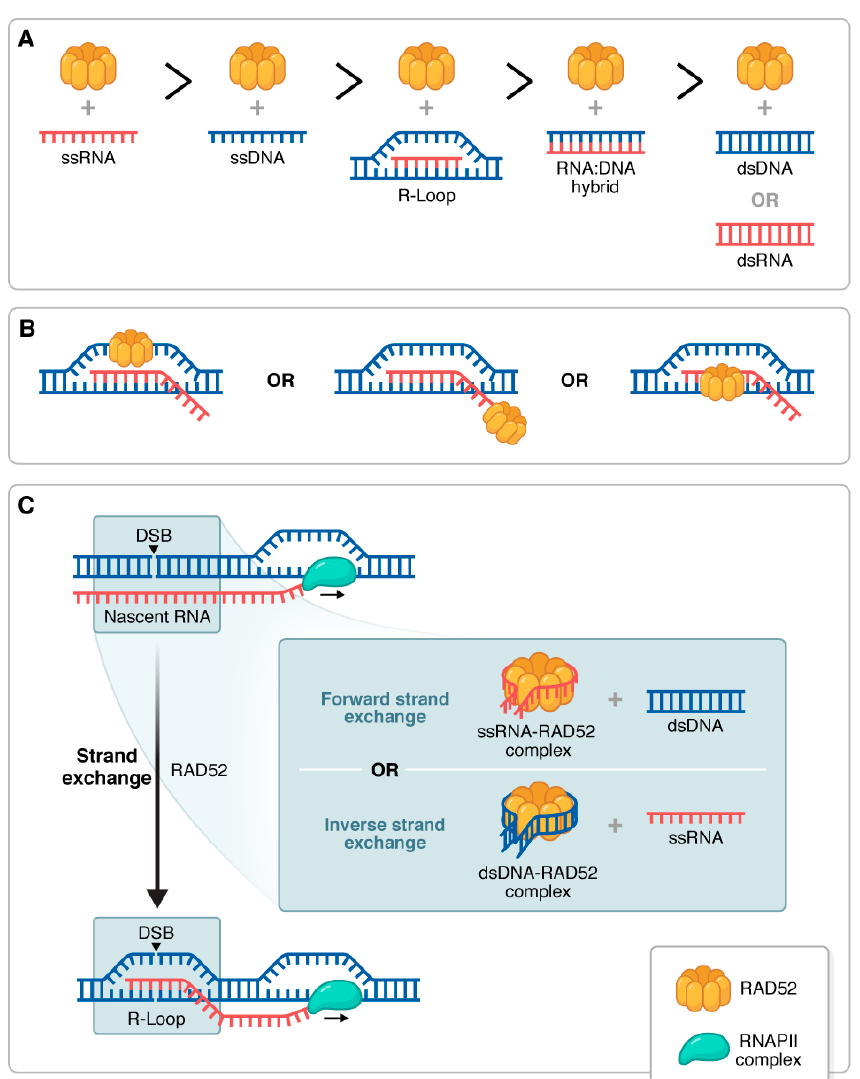
Figure 2. RAD52 and RNA-containing substrates. ( A ) Affinity of human RAD52 for various nucleic acid substrates adapted from mobility shift assay reported in Welty et al., 2017 [52]. ( B ) Possible modes of RAD52 binding at R-loops (to ssDNA, ssRNA, or RNA:DNA hybrid structure). ( C ) RAD52 may facilitate R-loop formation at a double-strand break by either forward or inverse strand exchange.